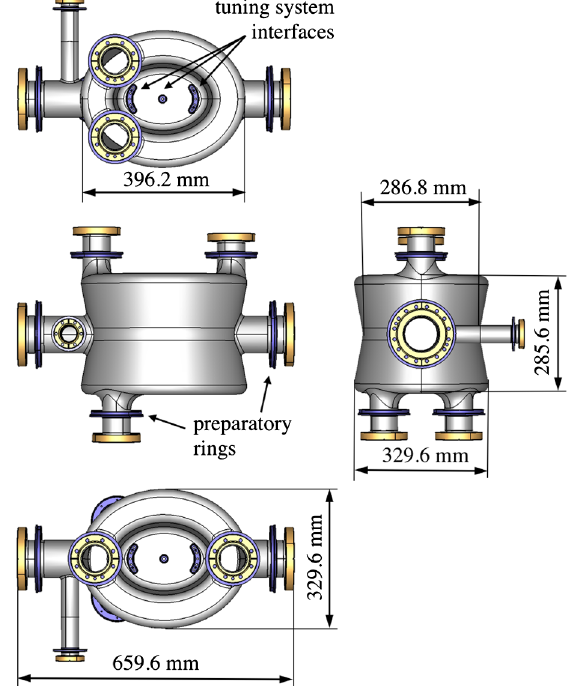
FIG. 2. Main dimensions at warm of the SPS-series DQW cavity